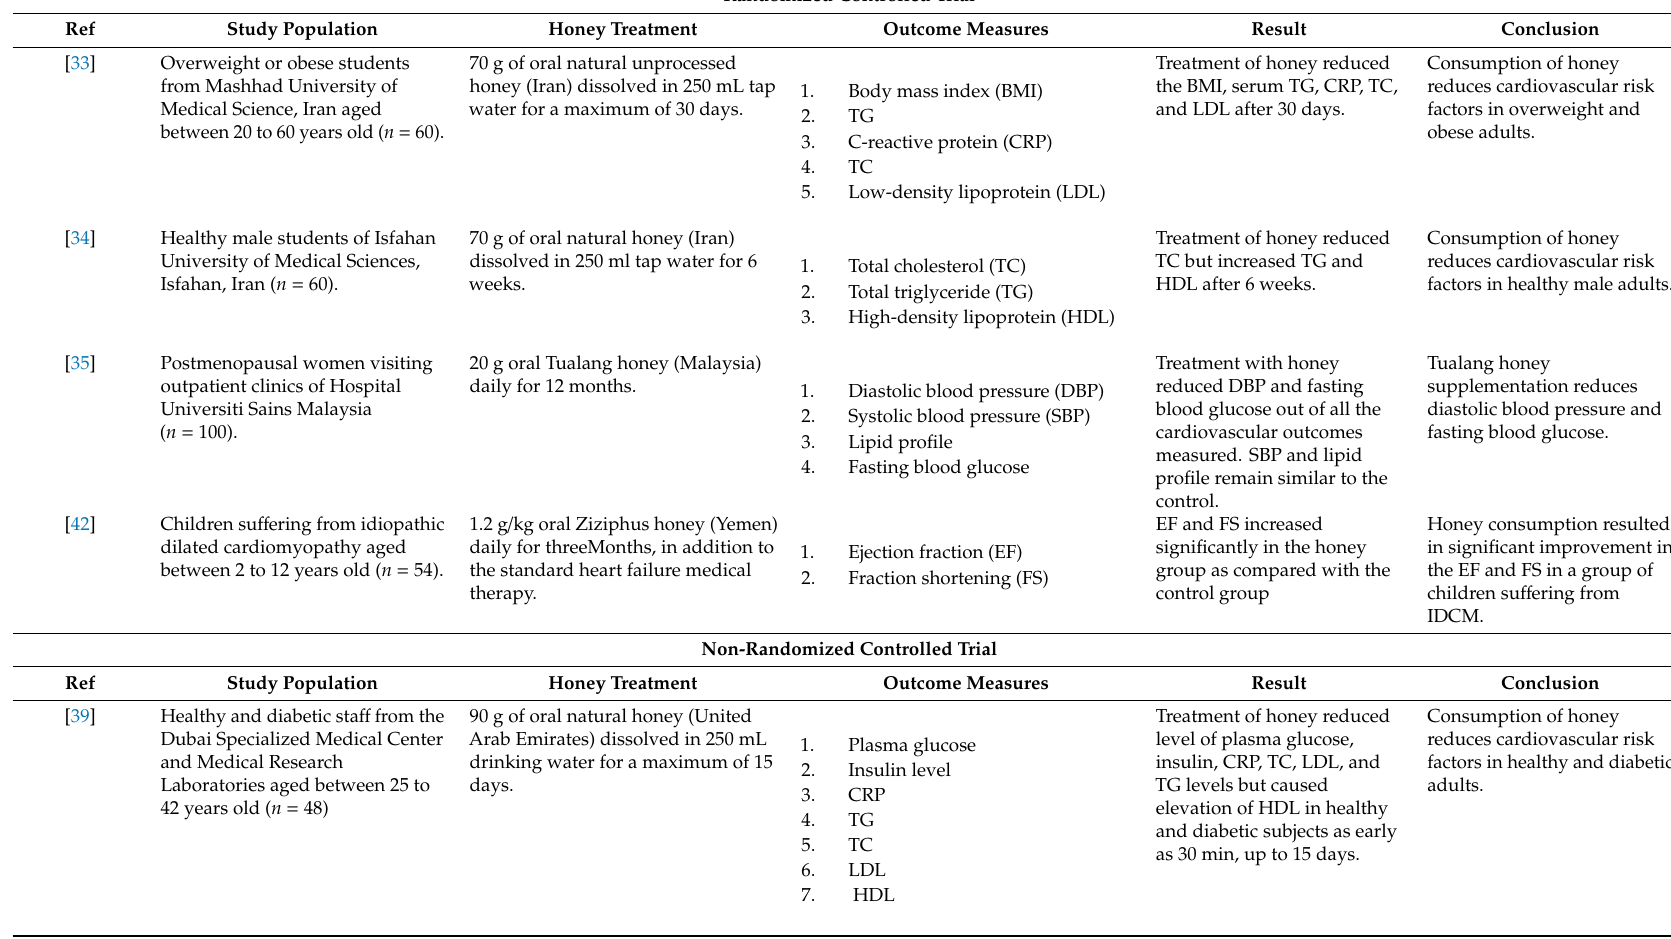
Table 2. Clinical evidence on the cardioprotective e ff ect of